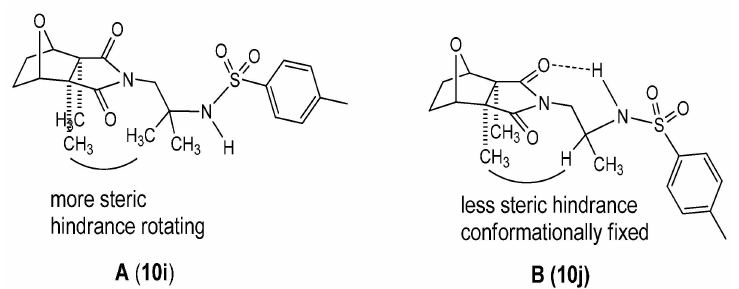
Figure 3. Conformation of 10i and 10j